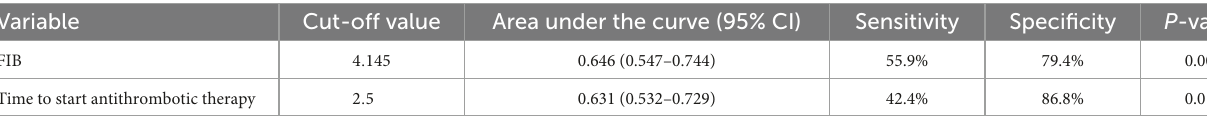
TABLE 2 The receiver operating characteristic (ROC) curve analysis of continuous variables with statistical significance. Variable